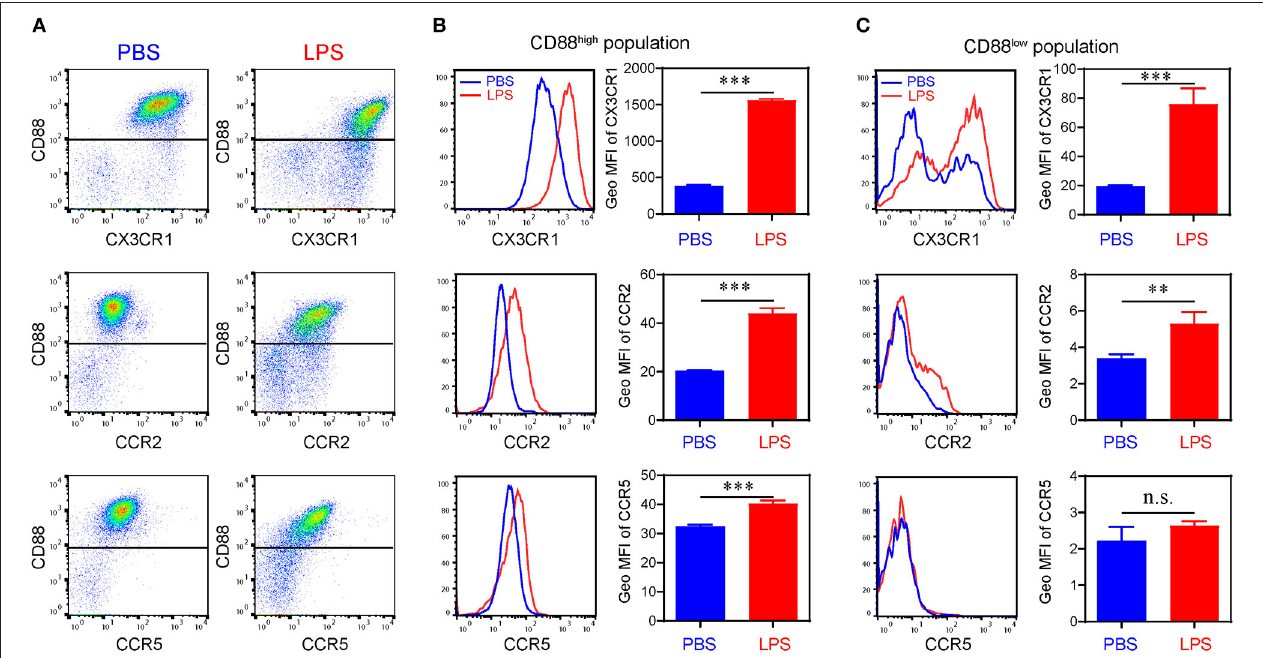
FIGURE 3 | Differential expression of chemokine receptors on bone marrow derived monocytes. (A) Representative flow cytometry data of the surface levels of CD88, CX3CR1, CCR2, and CCR5 on monocytes primed with PBS or super low dose LPS (100 pg/ml) for 5 d. (B) Representative histograms (left panels) and quantification of geometric mean fluorescence intensity (right panels) demonstrating CX3CR1, CCR2, and CCR5 expression on CD88 high population. (C) Representative histograms (left panels) and quantification of geometric mean fluorescence intensity (right panels) demonstrating CX3CR1, CCR2, and CCR5 expression on CD88 low population. n.s. not significant; ** P < 0.01; *** P < 0.001. Student’s